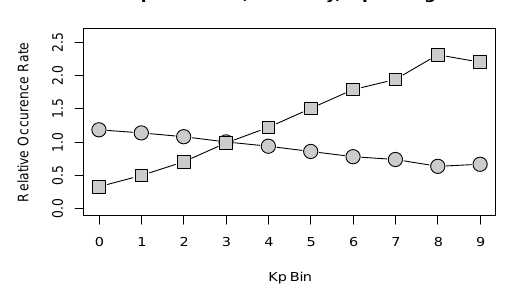
(cid:12) (cid:12) (cid:12) j 50Hz , peak (cid:12) . The thick line within